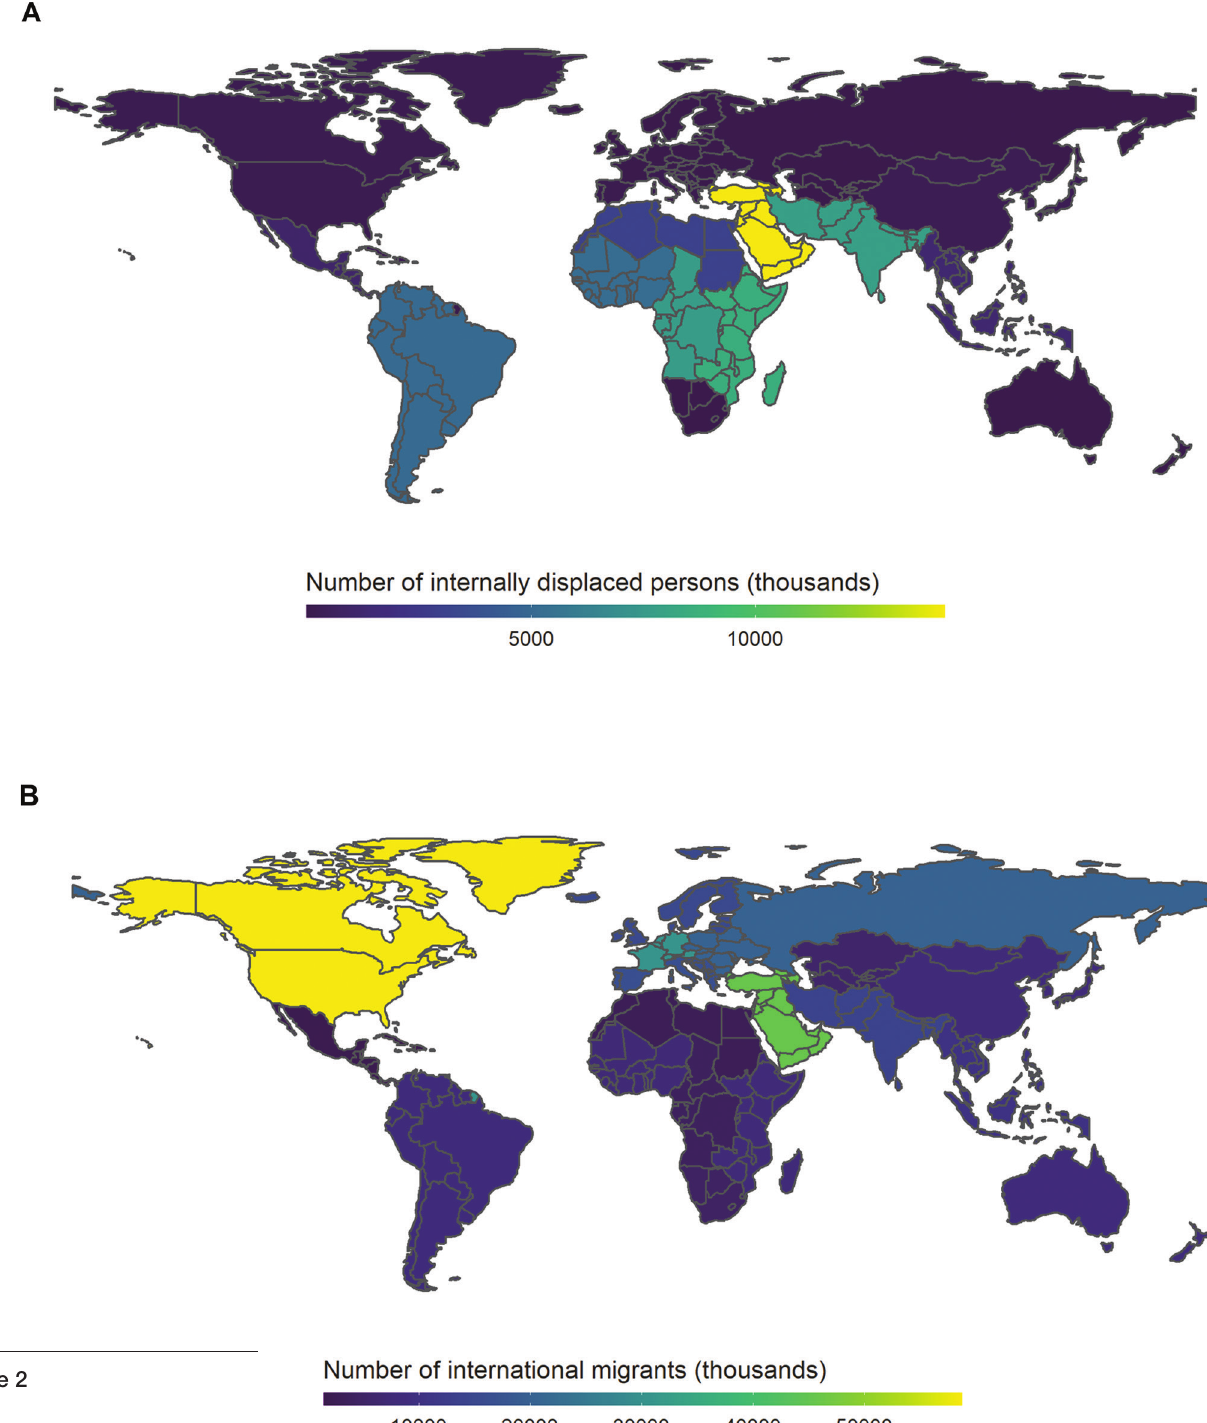
Global human migration by subregion. A) Number of internally displaced persons (from conflicts and disasters) in 2020 ranging from 22,000 in Eastern Europe (dark blue) to 14,200,000 in Western Asia (yellow); data were accessed via the Internal Displacement Monitoring Centre’s Global Internal Displacement database [35]. B) Number of international migrants in 2019 ranging from 1,542,000 in the Caribbean (dark blue) to 58,647,000 in North America (yellow); data were accessed via the UN Department of Economic and Social Affairs, Population Division database [36]. The legends for both graphs show the number of migrants in